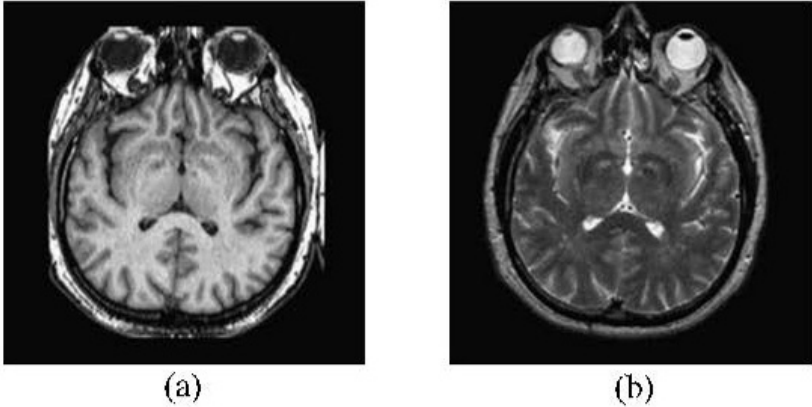
Figure 2. The Source Image Pair of Non-decomposition and Decomposition, ( a ) is the CT source image; and ( b ) is the MRI source image.